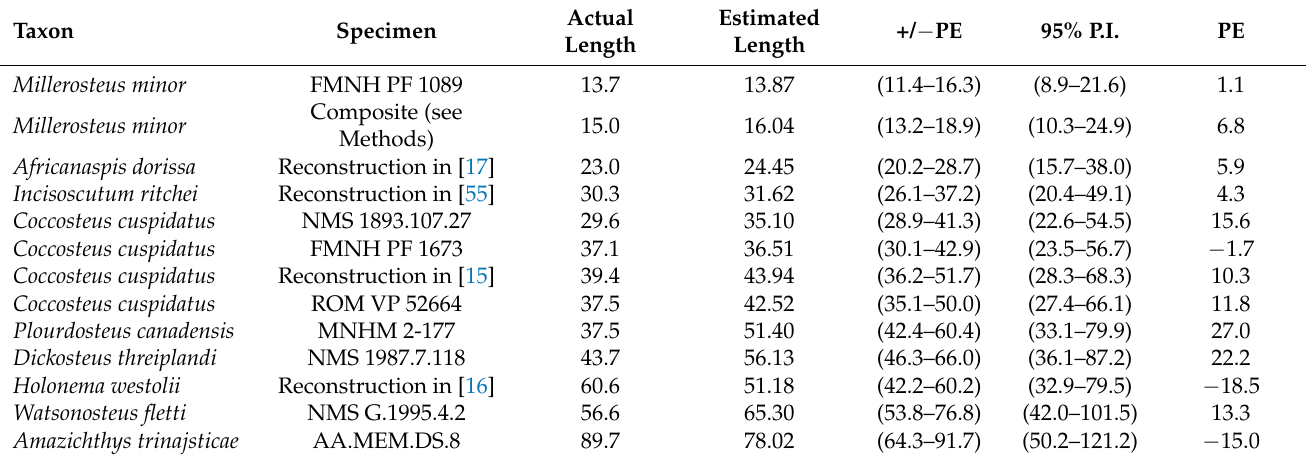
Table 2. Length estimates for arthrodires known from whole-body fossils using OOL from the all taxa, individual specimen equation. Selected representatives for each taxon are given in cases where more than one individual was measured for the sake of space, a complete listing of all results can be found in Supplementary File S3: Section S8. Abbreviations: PE, percent error; P.I., prediction interval. All measurements in